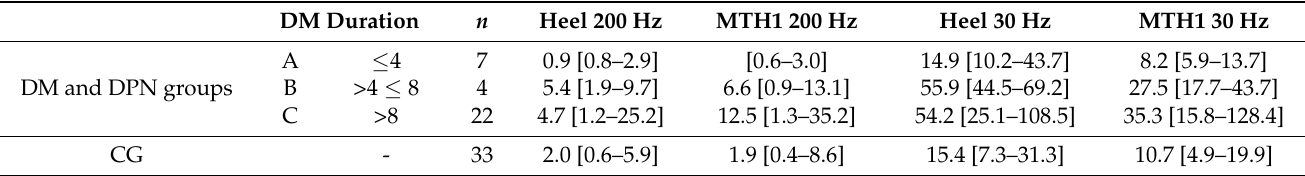
Table 3. Categorization of VPT data ( µ m) by DM duration